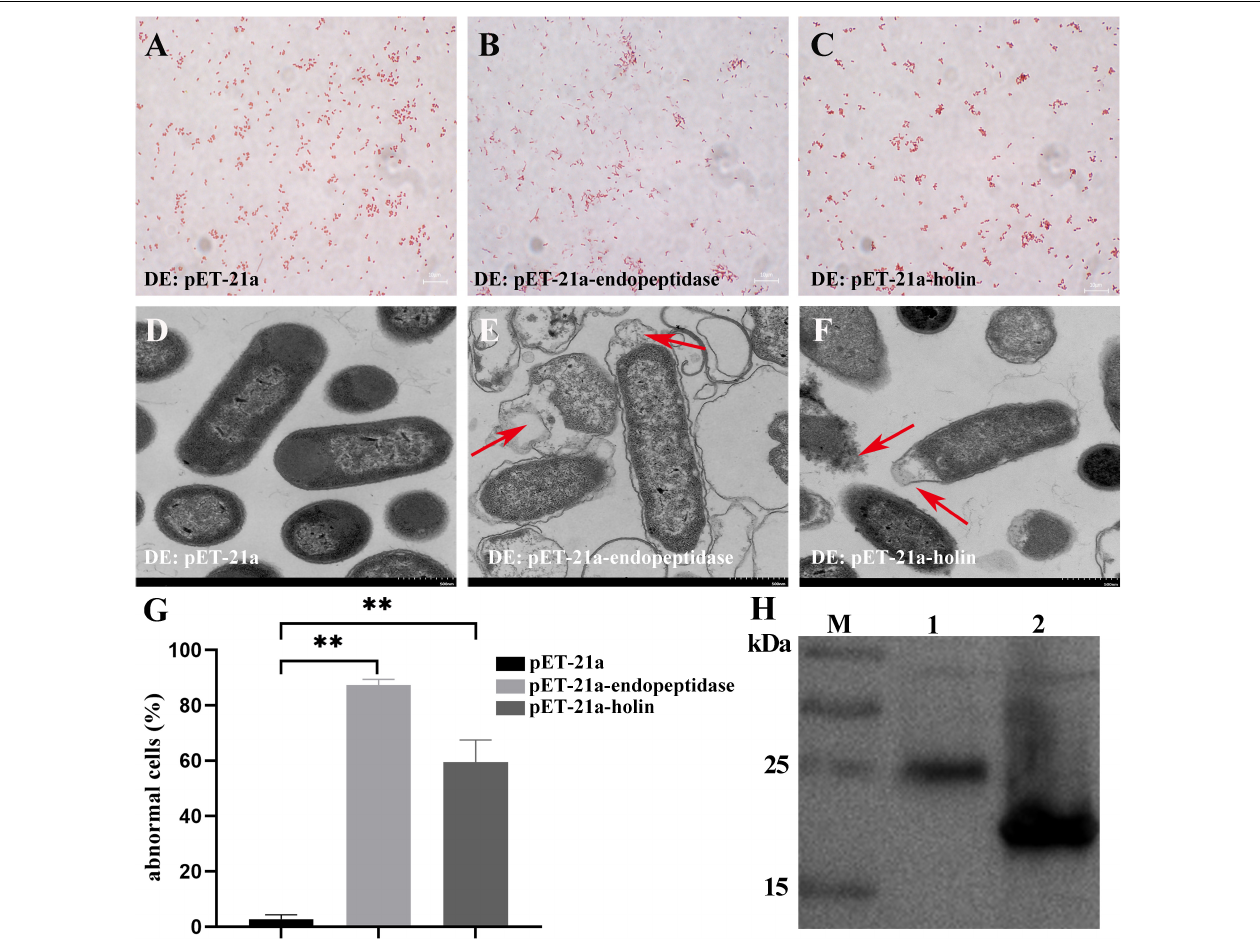
FIGURE 3 | Effect of endopeptidase and holin on E. coli cell morphology. (A) Gram staining of induced DE3: pET-21a. (B) Gram staining of induced DE3: pET-21a-endopeptidase. (C) Gram staining of induced DE3: pET-21a-holin. (D) Induced DE3: pET-21a under TEM. (E) Induced DE3: pET-21a-endopeptidase under TEM. (F) Induced DE3: pET-21a-holin under TEM. Red arrows in panels (E,F) indicate morphological changes. (G) Percentage of abnormal cells of different E. coli strains (DE3: pET-21a, DE3: pET-21a-endopeptidase, and pET-21a-holin). Each column represents the mean of three independent experiments, and error bars indicate the standard deviation. The “ ∗∗ ” indicates statistical significance (T-test, p < 0. 01). (H) The expression of endopeptidase and holin proteins was identified using Western blotting. M: protein marker; lane 1: a fusion endopeptidase protein ∼ 25 kDa; lane 2: a fusion holin protein ∼ 18